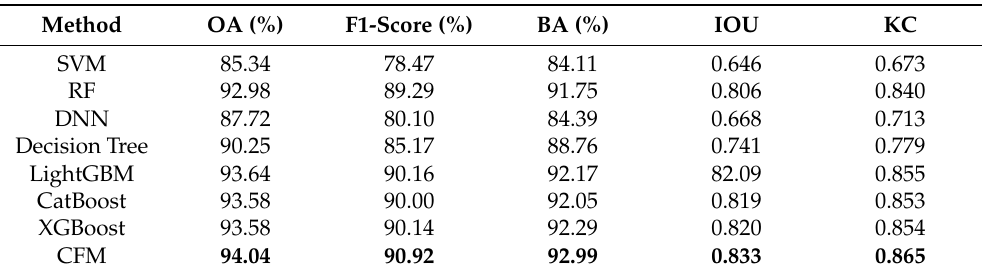
Table 4. Evaluation of the performance of different FSM models over the Karun basin. OA: overall accuracy; IOU: intersection over union, BA: balance accuracy; KC: kappa coefficient. Support Vector Machine (SVM), Random Forest (RF), Deep Neural Network (DNN), Decision Tree (DT), Light Gradient Boosting Machine (LightGBM), Categorical Boosting (CatBoost), Extreme Gradient Boosting (XGBoost), and Cascade Forest Model (CFM).The highest value is in bold.